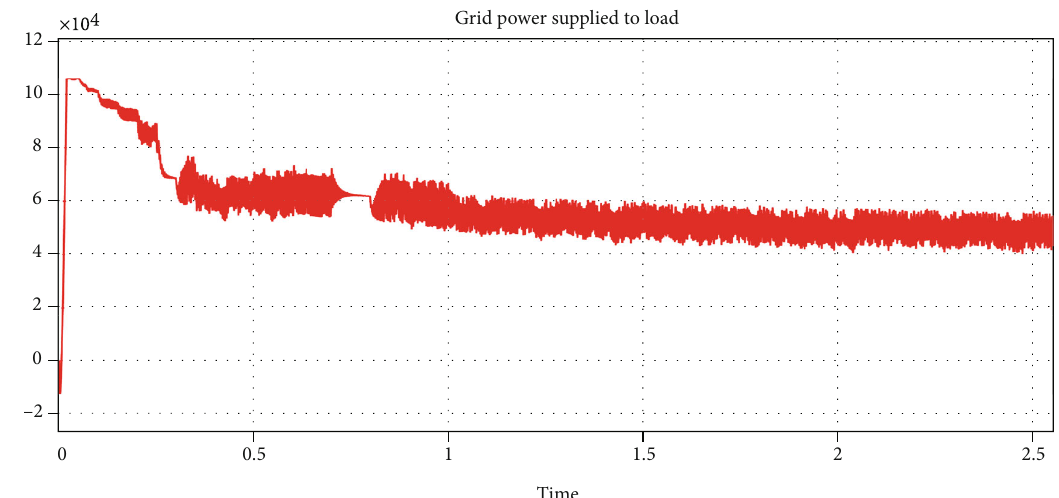
Figure 33: Grid-supplied power to the load.